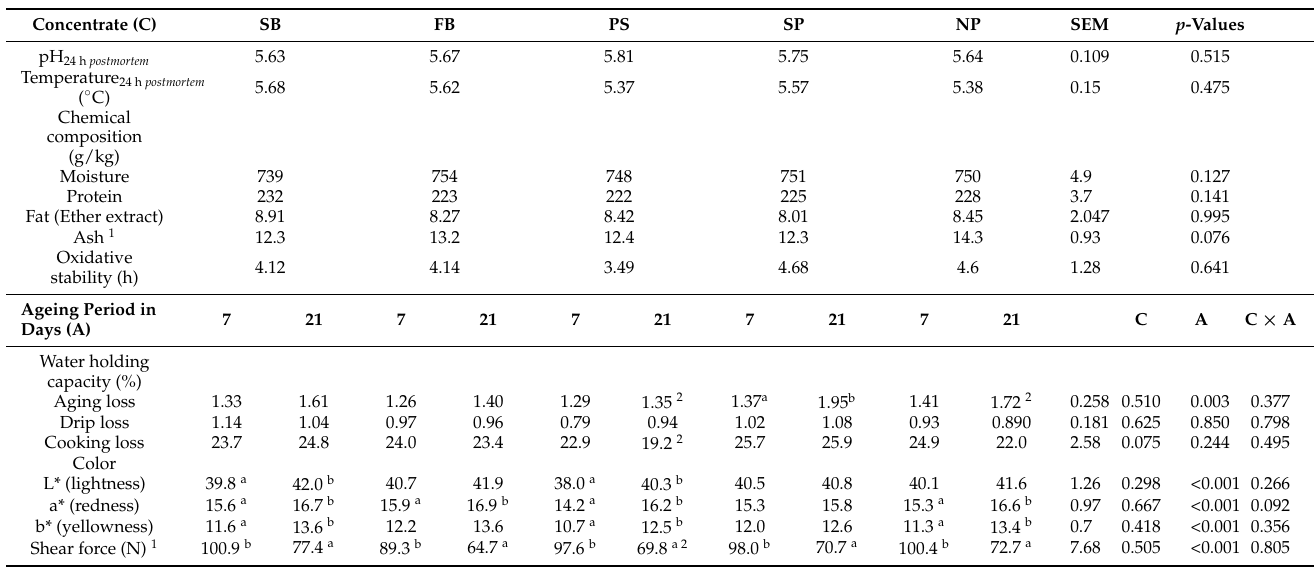
Table 5. Physicochemical quality of the longissimus thoracis et lumborum aged for 7 or 21 days from fattening bulls fed a grass/maize-silage based diet complemented with concentrates containing various protein sources or no additional protein source ( n = 6 per